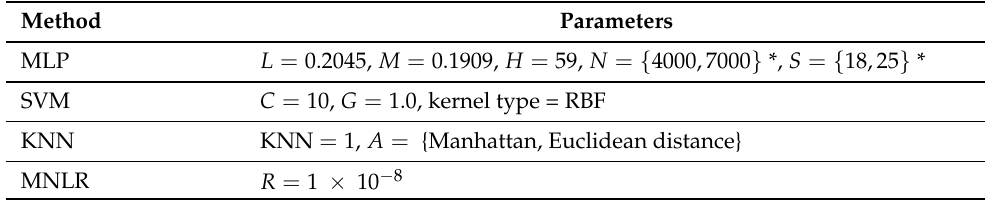
Table 14. Third experiment: classifiers’ configuration for the second test.